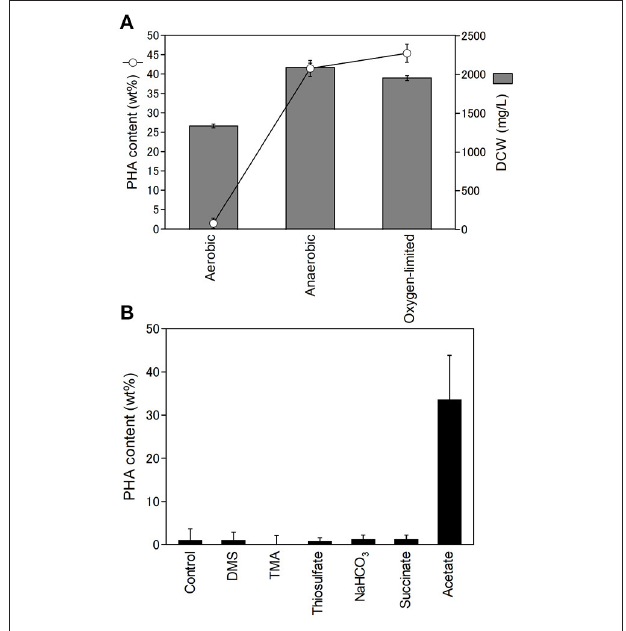
FIGURE 3 | Effect of oxygen concentration on cell growth and PHA production. (A) PHA content (open circles) and DCW (gray bars) under different oxygen conditions. Cells were cultured under aerobic, anaerobic and oxygen-limited conditions. (B) Effects of reductants and carbon sources on PHA production under aerobic conditions. Cells were cultured under aerobic conditions in the presence of 0.3% malate and 0.3% pyruvate supplemented with 10mM DMA (dimethylamine), 10mM TMA (trimethylamine) and 10mM thiosulfate as reductants and 20mM sodium bicarbonate, 0.5% sodium succinate and 0.5% sodium acetate as carbon sources. Data are the mean ± SD of at least three